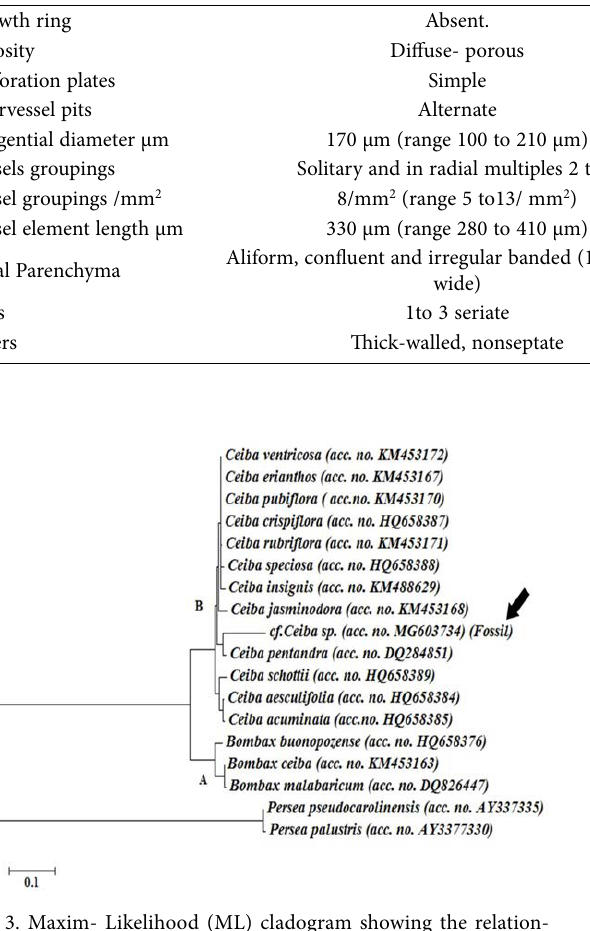
Table 9. Comparison of anatomical features between Dalbergioxylon dicorynioides & Dalbergia sissoo . Species Feature